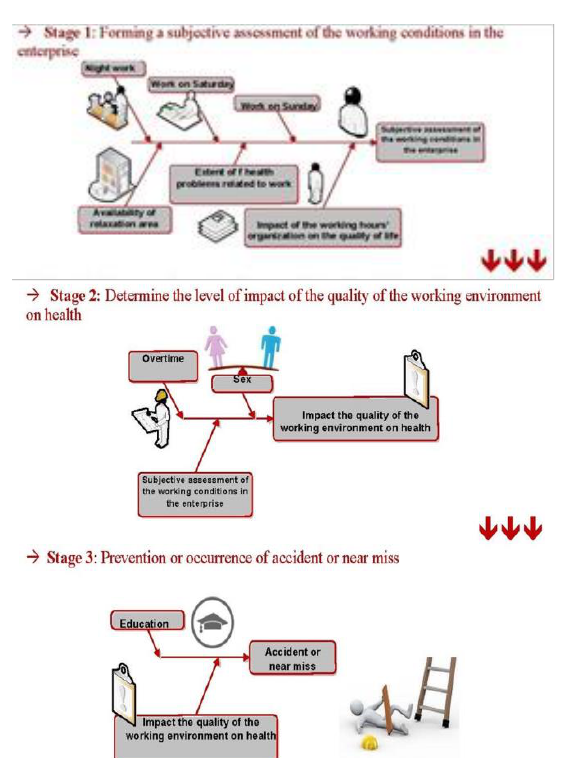
Figure 4. Impact mechanism of factors related to the working time organization on prevention or the occurrence of accidents or near